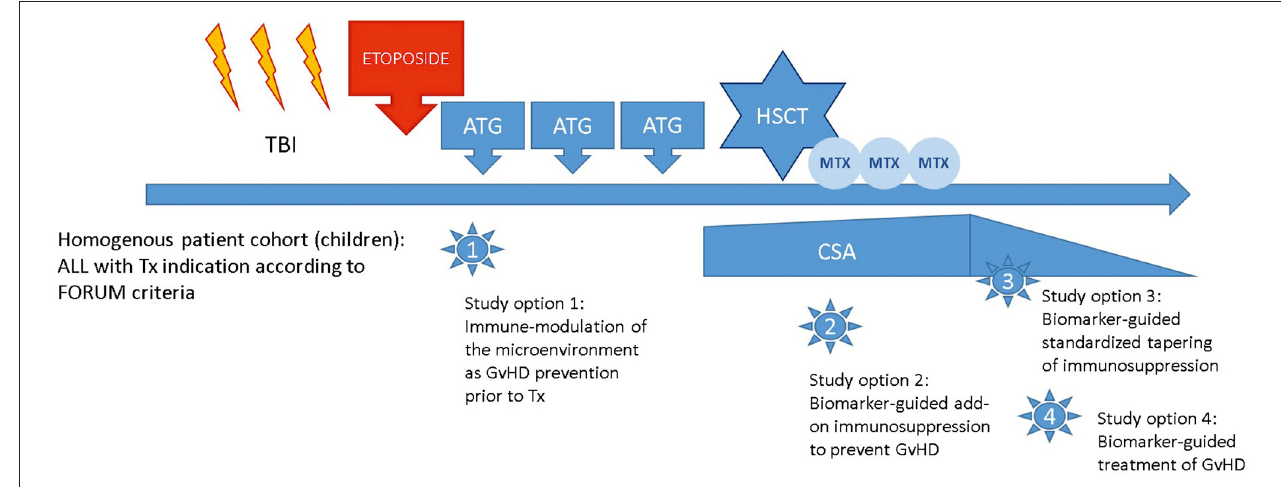
FIGURE 1 | Study options building on the PED-FORUM